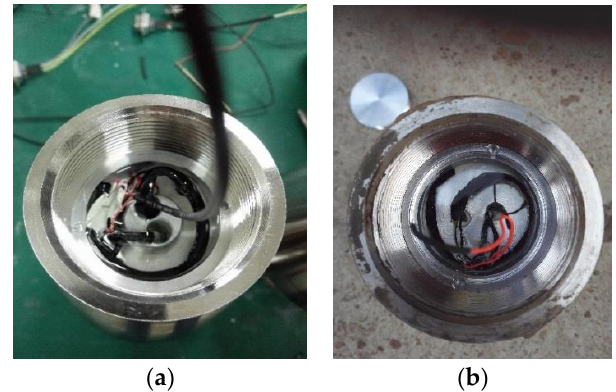
Figure 13. The photos of assembly. ( a) Assembly before experiment, ( b ) Recycled assembly.